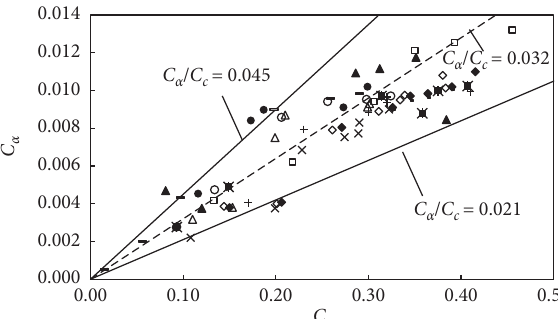
Figure 13: The relationship between the secondary consolidation coefficient and the compression index for oedometer